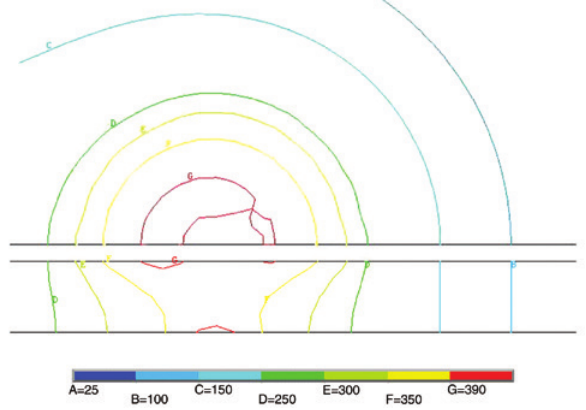
Figure 10: Local temperature field of TMAZ in the preheating period.